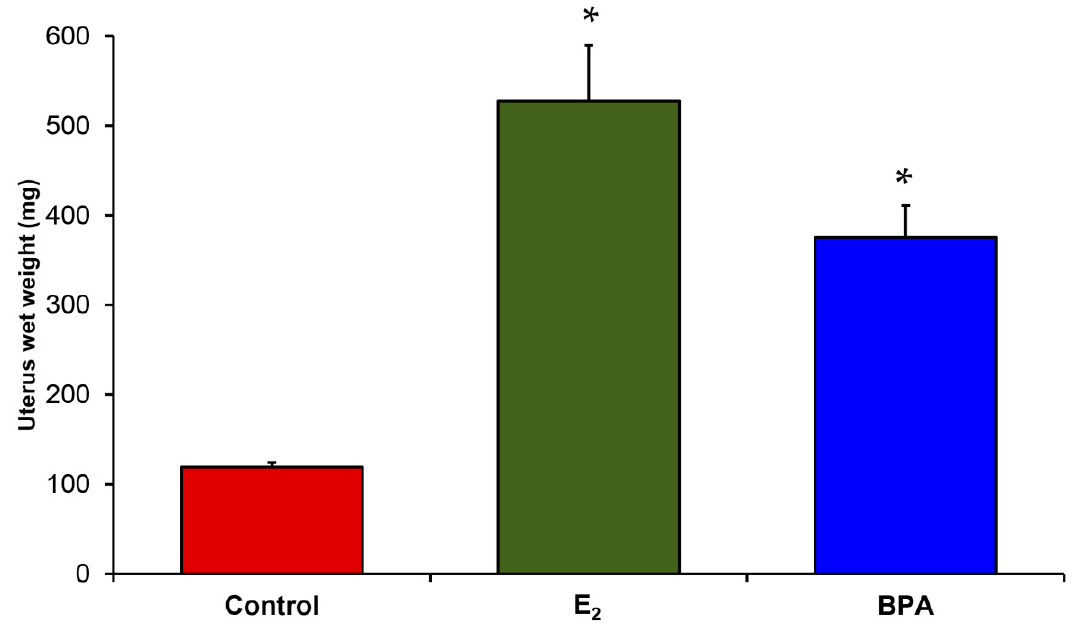
Figure 3. Uterus wet weights of E 2 -treated and BPA-treated OVX Sprague-Dawley rats compared to vehicle-treated controls in the reported experiment. Data are given as average ± standard error, and asterisks (*) indicate statistically significant differences from OVX controls with ANOVA followed by post hoc Dunnett’s tests ( p < 0.05).